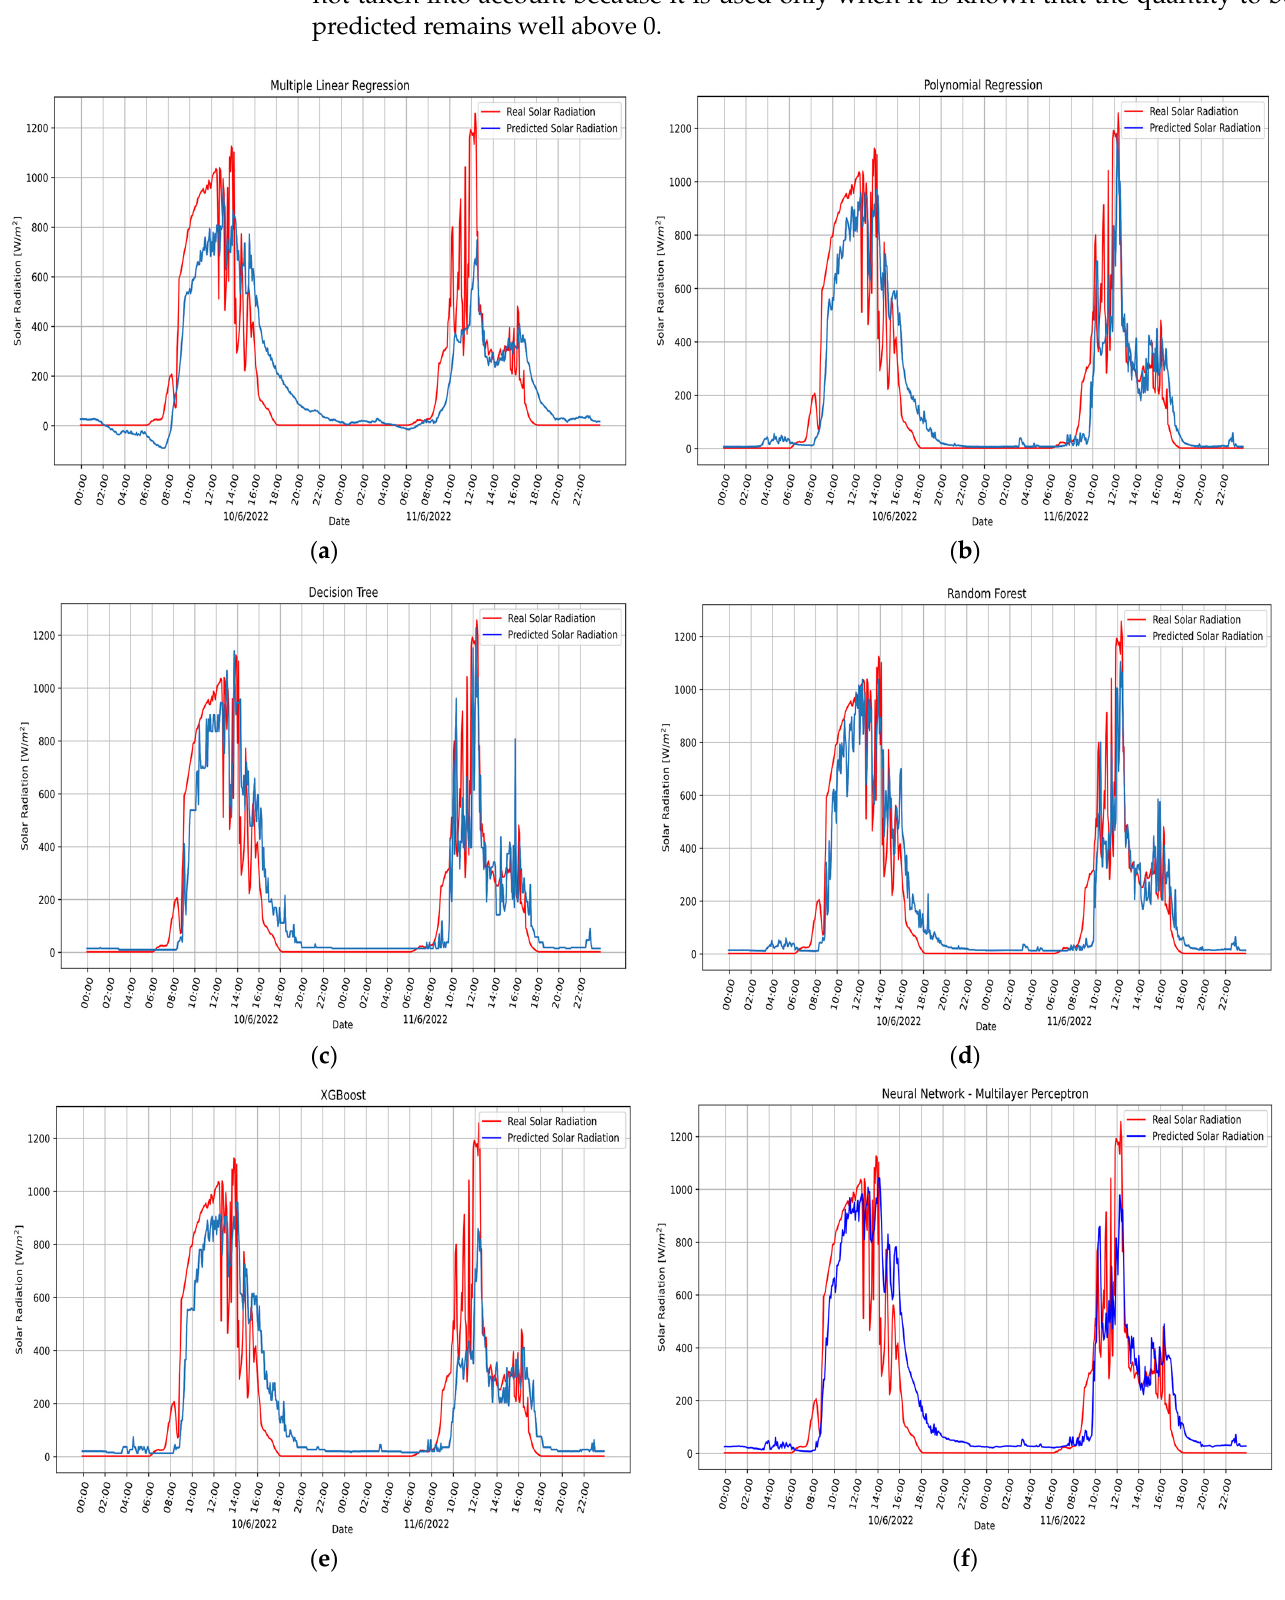
Figure 7. Solar radiation forecast techniques: ( a ) Multiple linear regression, ( b ) Polynomial regression, ( c ) Decision tree, ( d ) Random forest, ( e ) XGboost, ( f ) Multilayer perceptron neural